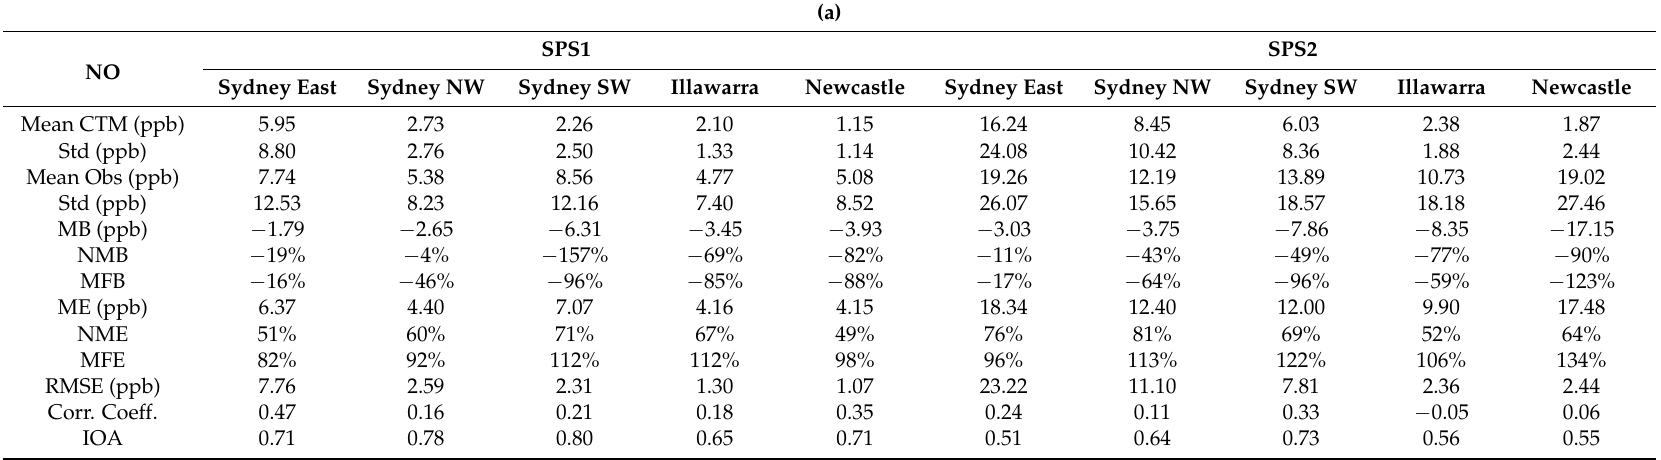
Table A3. Quantitative performance statistics for predicted hourly ( a ) NO, ( b ) CO and ( c ) SO 2 concentrations against observations in the Sydney East, Sydney NW, Sydney SW, Illawarra and Newcastle regions for the periods of SPS1 and SPS2. Table (a) illustrates the CCAM-CTM has a tendency to underpredict hourly NO concentrations with values of MB (ME) in a range of − 1.79 to − 6.31 ppb (4.15 to 7.07 ppb) in SPS1 and − 3.03 to − 17.15 ppb (9.9 to 18.34 ppb) in SPS2 across regions. The model generally performs better in predicting NO in the Sydney East and Sydney SW regions, in terms of higher values of correlation coefficient and IOA are found in both regions during SPS1 and SPS2, while the lowest values of correlation coefficient and IOA are found in the Illawarra region in both periods. The CCAM-CTM shows a larger tendency to underpredict hourly CO concentrations with values of MB (ME) vary from − 40.37 to − 233.74 ppb (48.67 to 251.71 ppb) during SPS1 and SPS2. Relatively higher values of correlation coefficient (0.42 to 0.45) and IOA (0.64 to 0.73) are found in the Sydney East region in both SPS1 and SPS2. Quantitative performance statistics for predicted hourly SO 2 concentrations are summarised in Table (c). The model generally overpredict SO 2 with values of MB (ME) in a range of 0.36 to 0.89 ppb (0.83 to 2.25 ppb) in both periods. Higher values of IOA are found in the Sydney NW and SW regions (0.81 to 0.9), while higher values of correlation coefficient (0.57) was found in